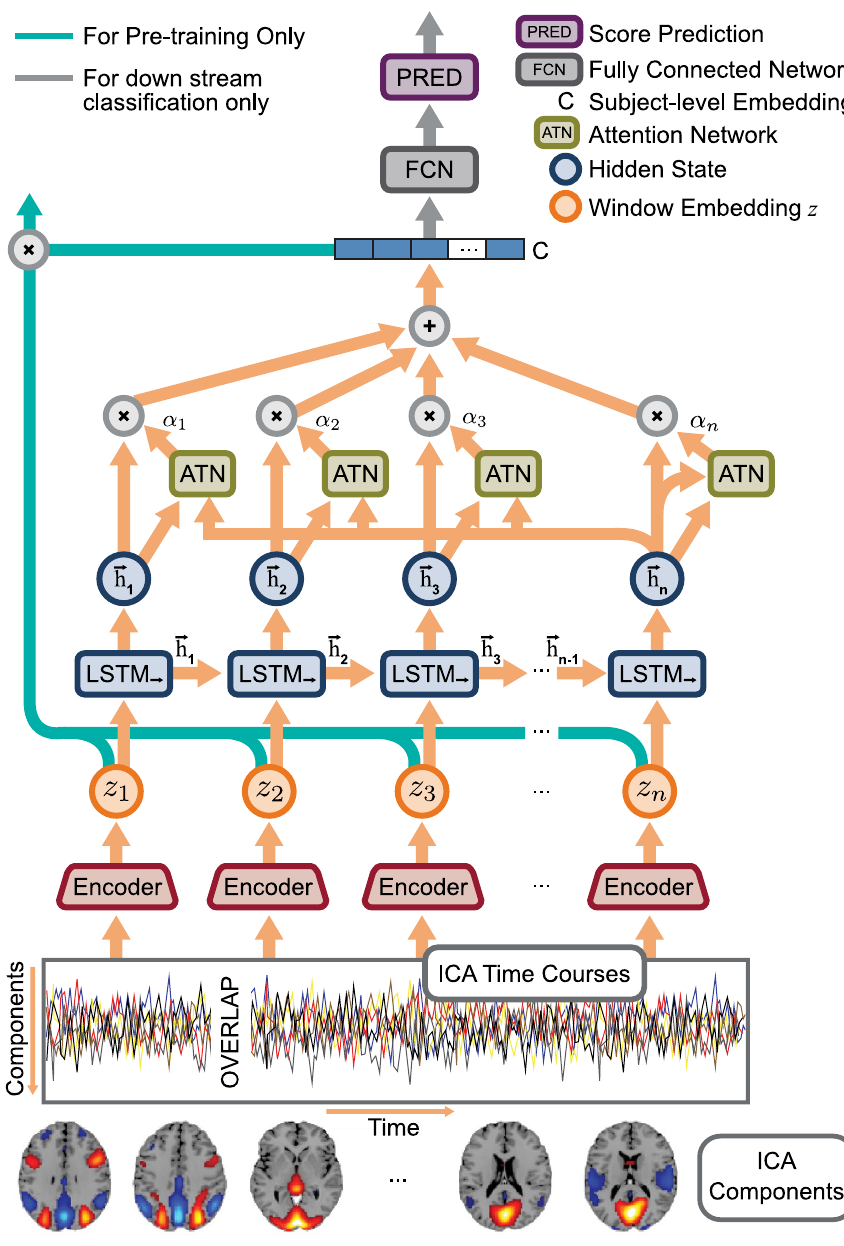
Figure 7. The whole MILC architecture—an attention-based top-down recurrent network (created in programs Adobe Illustrator 26.0.3, http:// ww. adobe. com/ produ cts/ illus trator. html and Inkscape 1.1.2, http:// inksc ape. org/ relea se/ inksc ape-1. 1.2). Precisely, we used an LSTM network with an attention mechanism as a parameter- shared encoder to generate the latent embeddings z for the sliding window at all relevant positions. The top LSTM network (marked as LSTM) used these embeddings ( z ) to obtain the global representation c for the entire subject. During pretraining, we intended to maximize the mutual information between z and c . In the downstream classification task, we used the global representation c directly as input to a fully connected network for predictions. Based on these predictions, we estimated feature attributions using different interpretability methods. Finally, we evaluated the feature attributions using the RAR method and an SVM